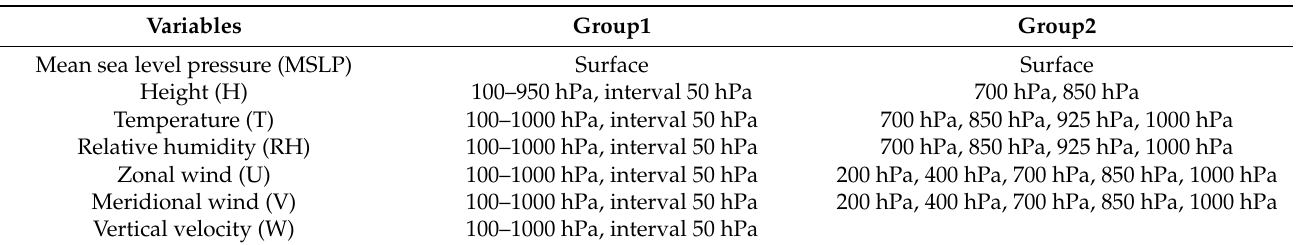
Table 1. List of variables at selected levels that were used as predictors in group1 and group2 experiments. Variables Group1 Group2 Mean sea level pressure (MSLP)